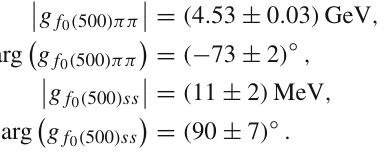
tion slightly shifts the imaginary parts of the poles with respect to the